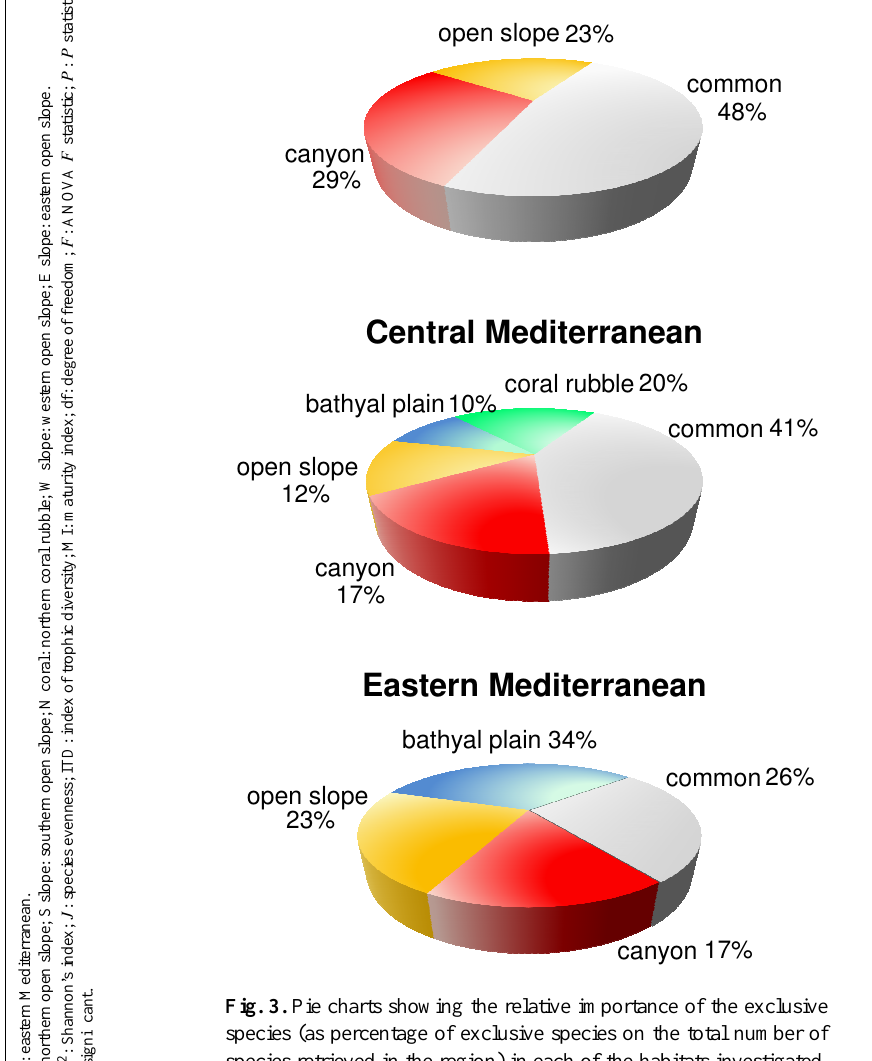
high values are responsible for the high γ diversity (i.e. re- gional diversity; Fig. 5b), which shows the highest values (210 species) in the central Mediterranean and the lowest (120 species) in the eastern Mediterranean Sea, as illustrated in Fig. 6. Even when the γ and ε diversities were calcu- lated by means of estimators (Chao1 and Chao2), the same patterns were observed, with the highest level recorded in the central Mediterranean Sea. Plots of randomised, cumu- lative Chao2 estimates against number of samples show that species curves for all the investigated regions (except for the eastern Mediterranean Sea), and for regions combined, ap- proached an asymptote (Fig.